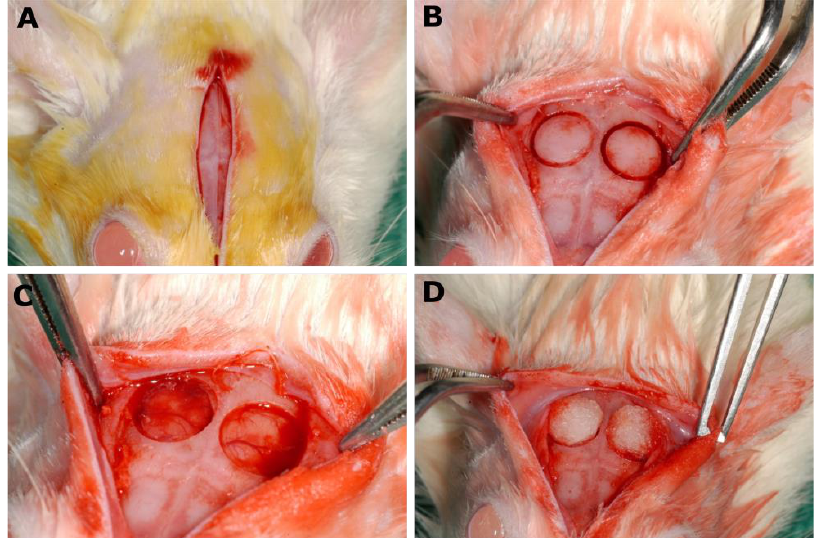
Figure 1. Pictures of the surgical interventions. ( A ) Incision along the sagittal midline of the cranium; ( B ) After the use of trephine bur; ( C ) Empty cavities; ( D ) Placement of the collagen membrane.